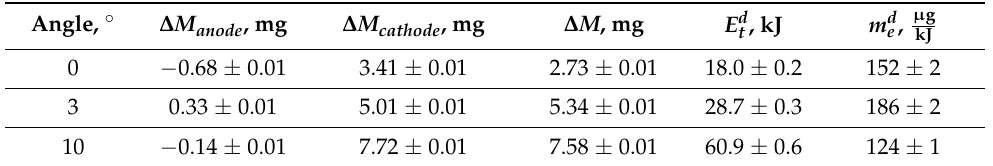
Table 2. The electrodes’ mass loss, the energy release in the interelectrode gap, and the energy efficiency of the NP synthesis with the